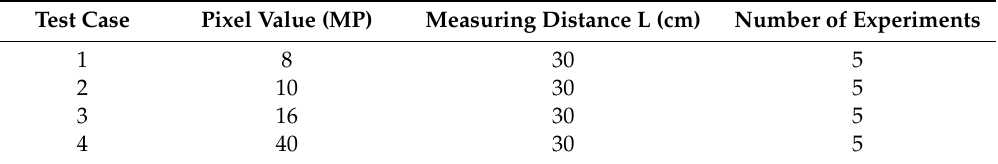
Table 1. Test cases used in the